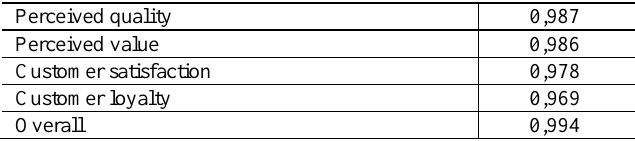
Table 2: Reliability results